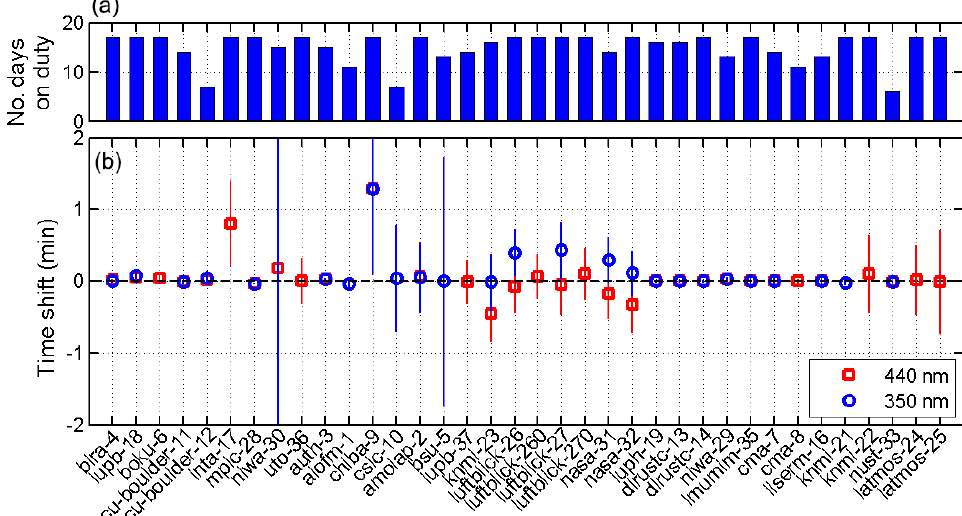
Figure 2. (a) The number of days when instruments were on duty during the 17d intercomparison period. (b) The mean and standard deviation of the time deviations (in decimal minutes) observed in the MAX-DOAS measurements as reported by each participating group with respect to the measurement schedule defined for the campaign. Note that the instruments are listed in order of how they are categorised, and this is further explained in Sect.